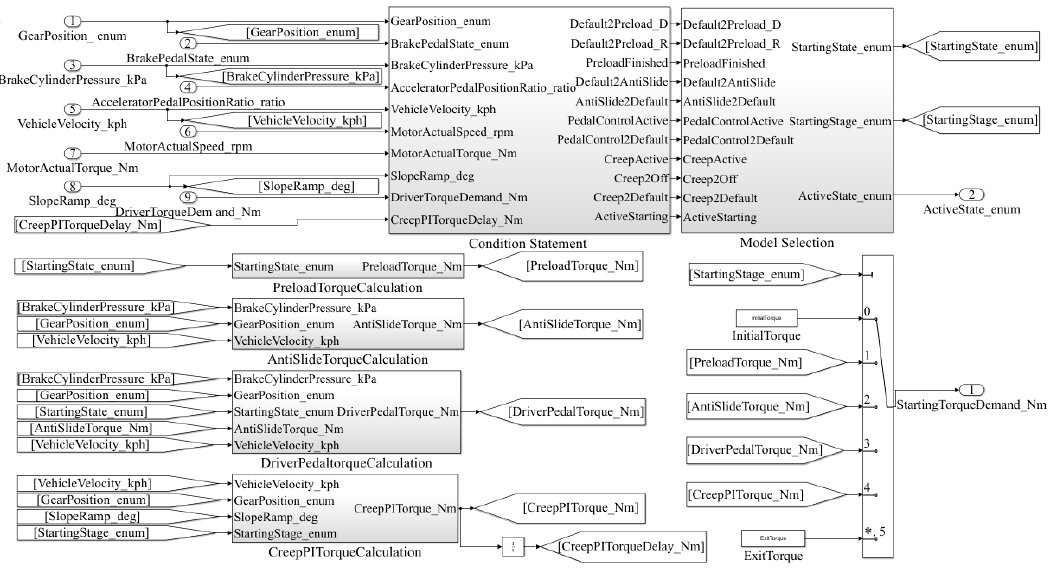
Figure 5. Starting Control Strategy Model Based on State Machine.